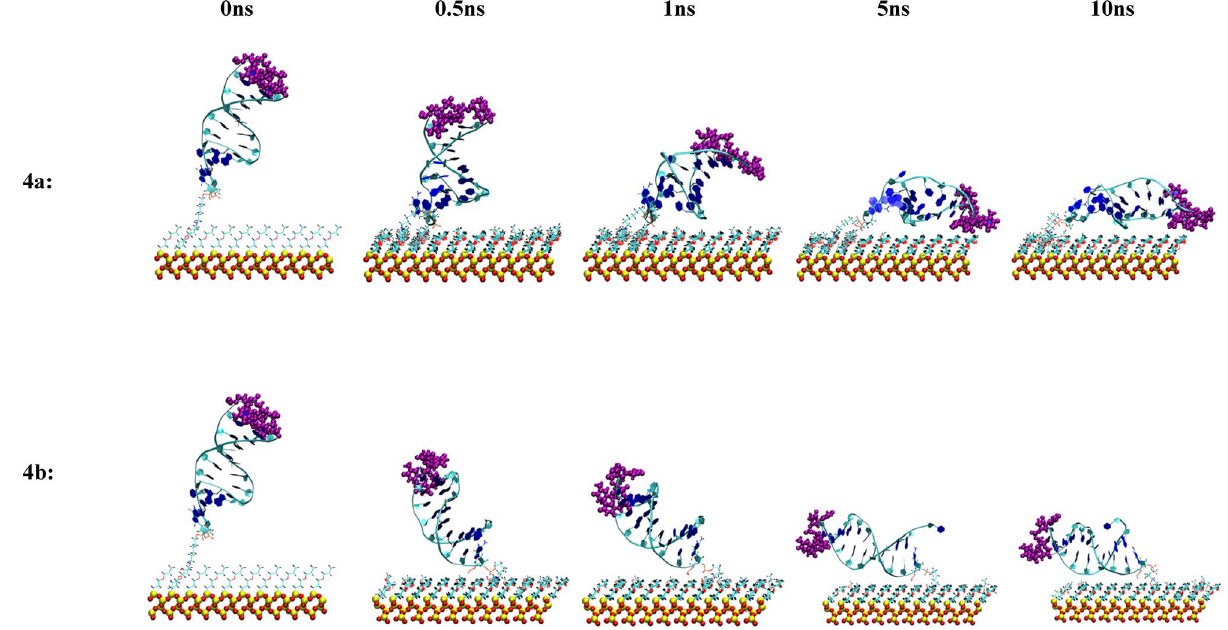
Figure 11. Snapshots of the MD simulation of the anti MUC1 aptamer tethered to the SiO 2 biosensor substrate in configuration 4 (3 ′ end attachment, perpendicular to surface, low density) neutralized (top) and in 0.8 M (bottom) solution concentrations at 0 ns, 0.5 ns, 1 ns, 5 ns, and 10 ns. The MUC1 binding residues (thymine residues 11 and 13) are displayed in purple.